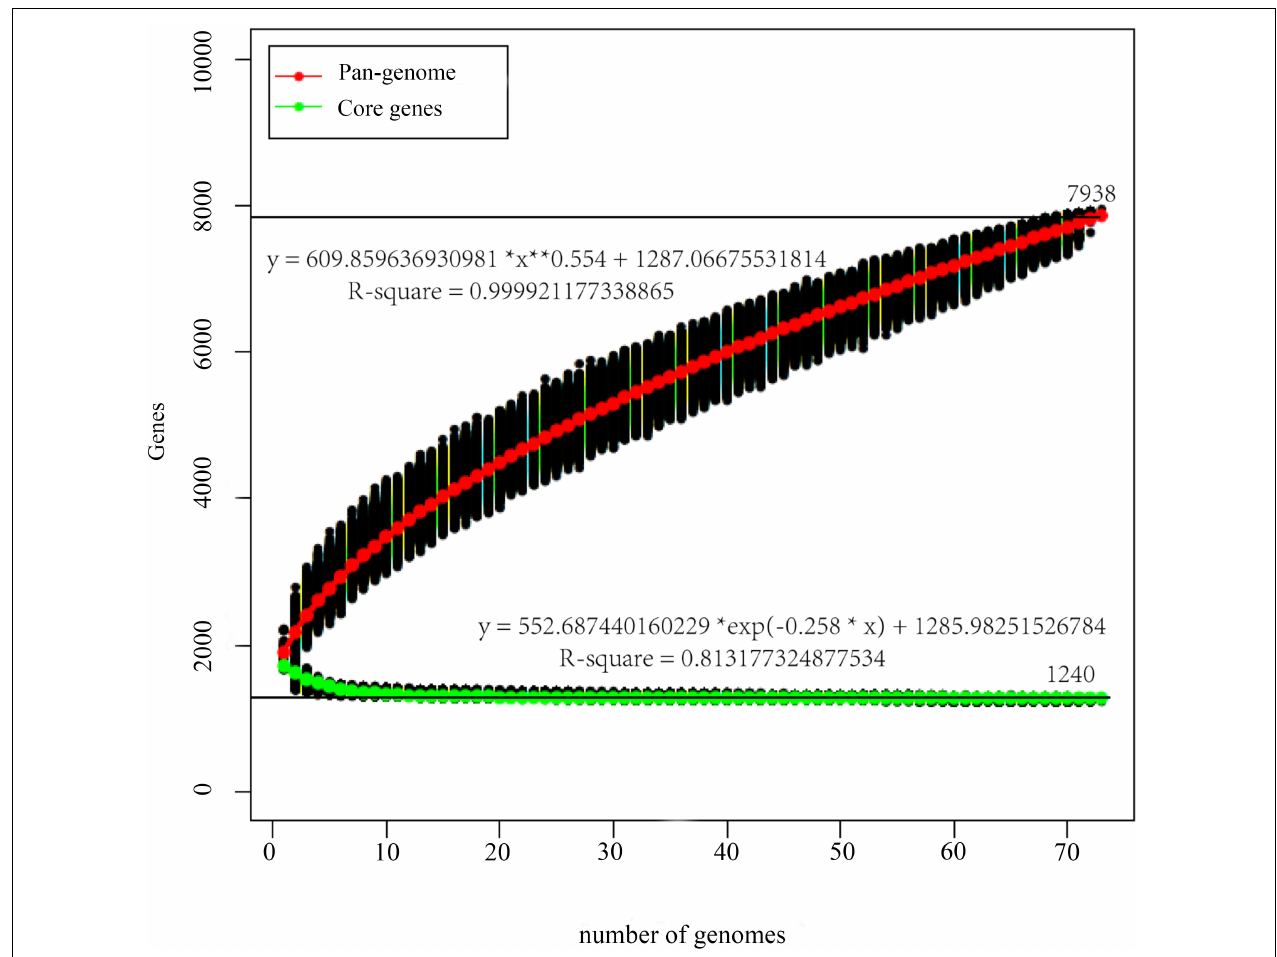
FIGURE 1 | Pan-genome and core-genome of P. pentosaceus. The pan-genome plot is represented by the accumulated number of new genes against the number of genomes added. The core-genome plot is represented by the accumulated number of genes attributed to the core-genomes against the number of added genomes. The black line represents the pan-genome and core-genome attributed to the 73 P. pentosaceus